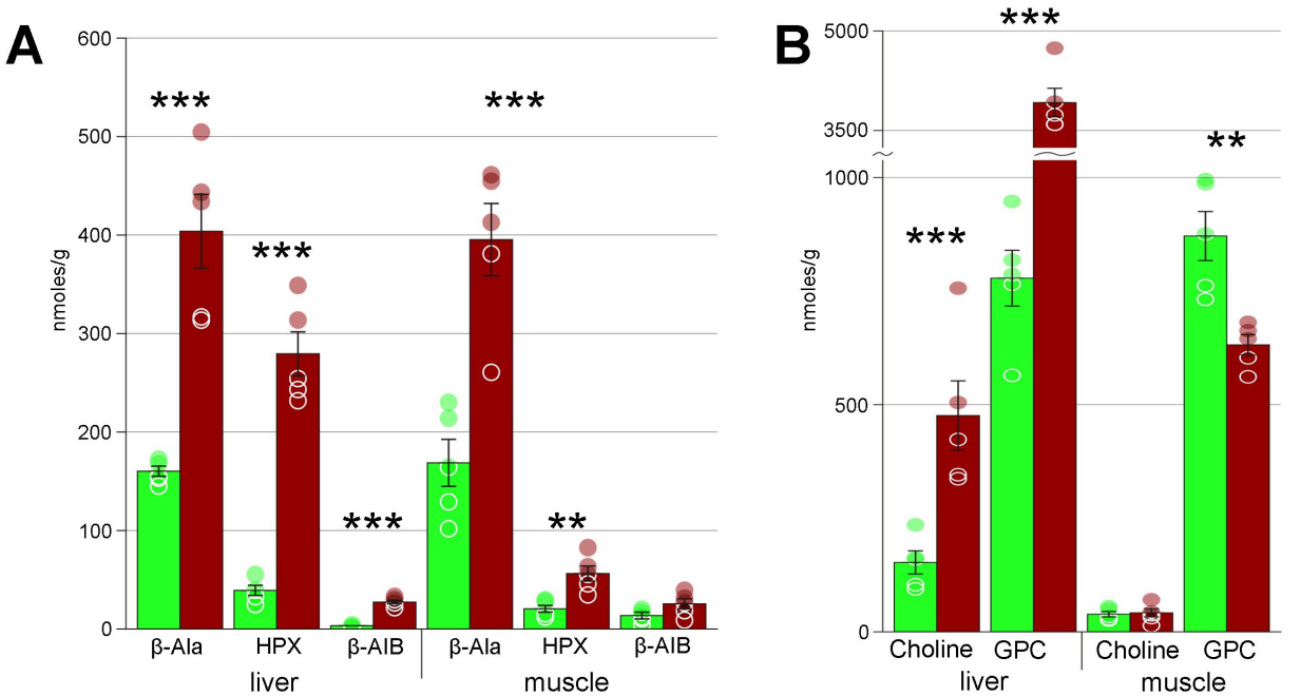
Figure 5. ( A ) products of nucleotide degradation: β -Ala, β -alanine; HPX, hypoxanthine; β -AIB, β -aminoisobutyrate. ( B ) Products of biomembrane degradation: GPC, glycerophosphocholine. Green columns, control; red, frozen; ** Welch test p < 0.01; *** p < 0.001; circles, individual data points; bar, SE.